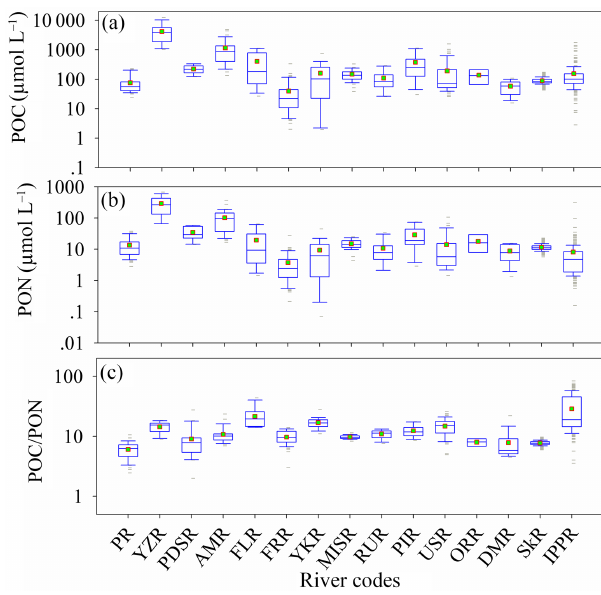
Figure 8. Variation of PON, POC and POC / PON in river wa- ters. PR is Pearl River (China), YZR is Yangtze River (China), PDSR is Paraiba do Sul river (Brazil), AMR is Amazon River (Brazil), FLR is Fly River (Papua New Guinea), FRR is Fraser River (Canada), YKR is Yukon River (USA), MISR is Mississippi River (USA), RUR is Russian rivers (Russia), PIR is Ping River (Thai- land), USR is Union and Skokomish rivers (USA), ORR is Orinoco River (Venezuela), DMR is Mandovi River (India), SkR is Skid- away River (USA), and IPPR is Ipswich and Parker rivers